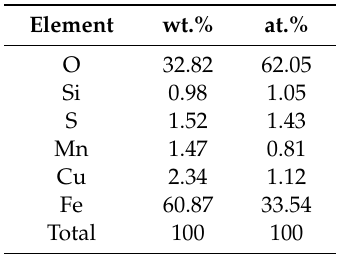
Table 2. Chemical composition of the oxide scale formed on the surface of C45 steel after its grinding to a depth of 20 µ